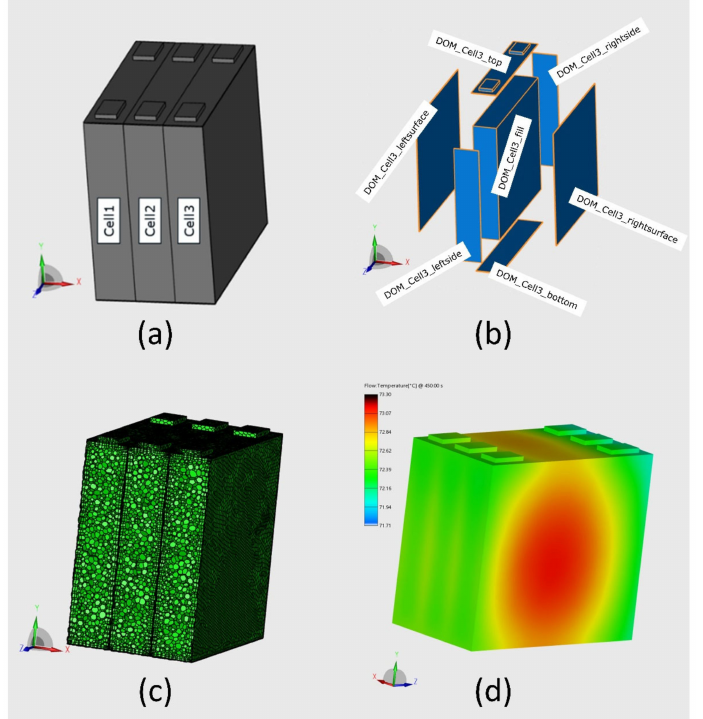
Figure 6. Overview of the 3D battery module modeling steps; ( a ) CAD design, ( b ) Domain specifica- tion, ( c ) Meshing process, and ( d ) model performance and simulation post-processing.